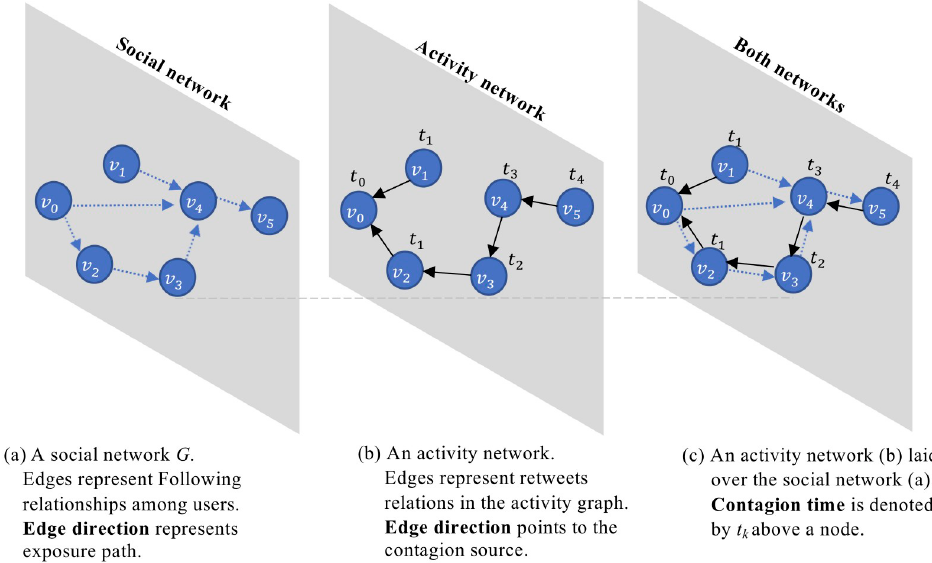
Fig 1. An activity network with a social network. Distances are measured on the social